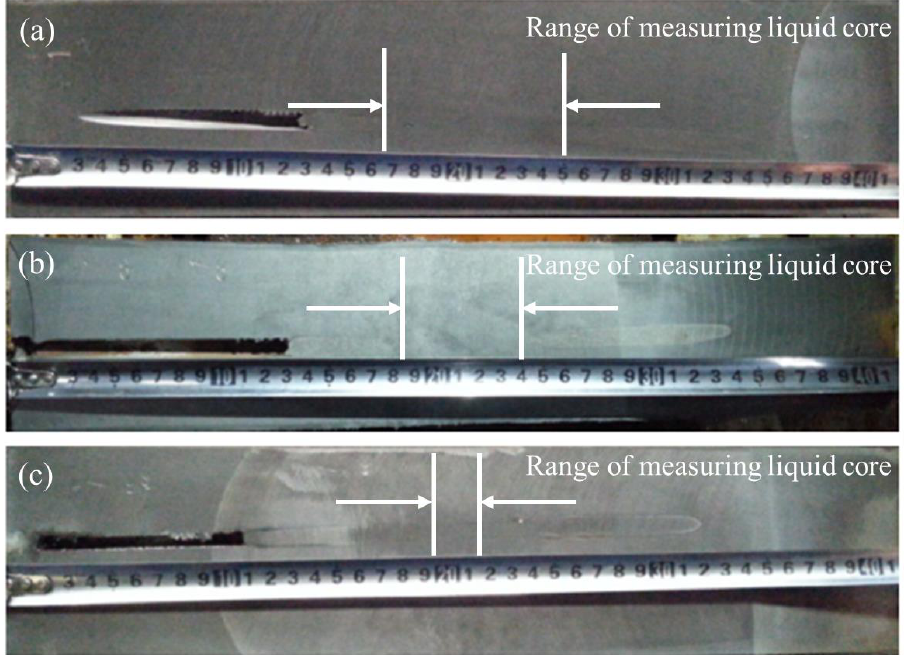
Figure 3. Photographs of sulfur printing samples for nail-shooting experiments: ( a ) the end of seg- ment 7; ( b ) the end of segment 8; ( c ) the end of segment 9. The white arrows represent the range of liquid core.